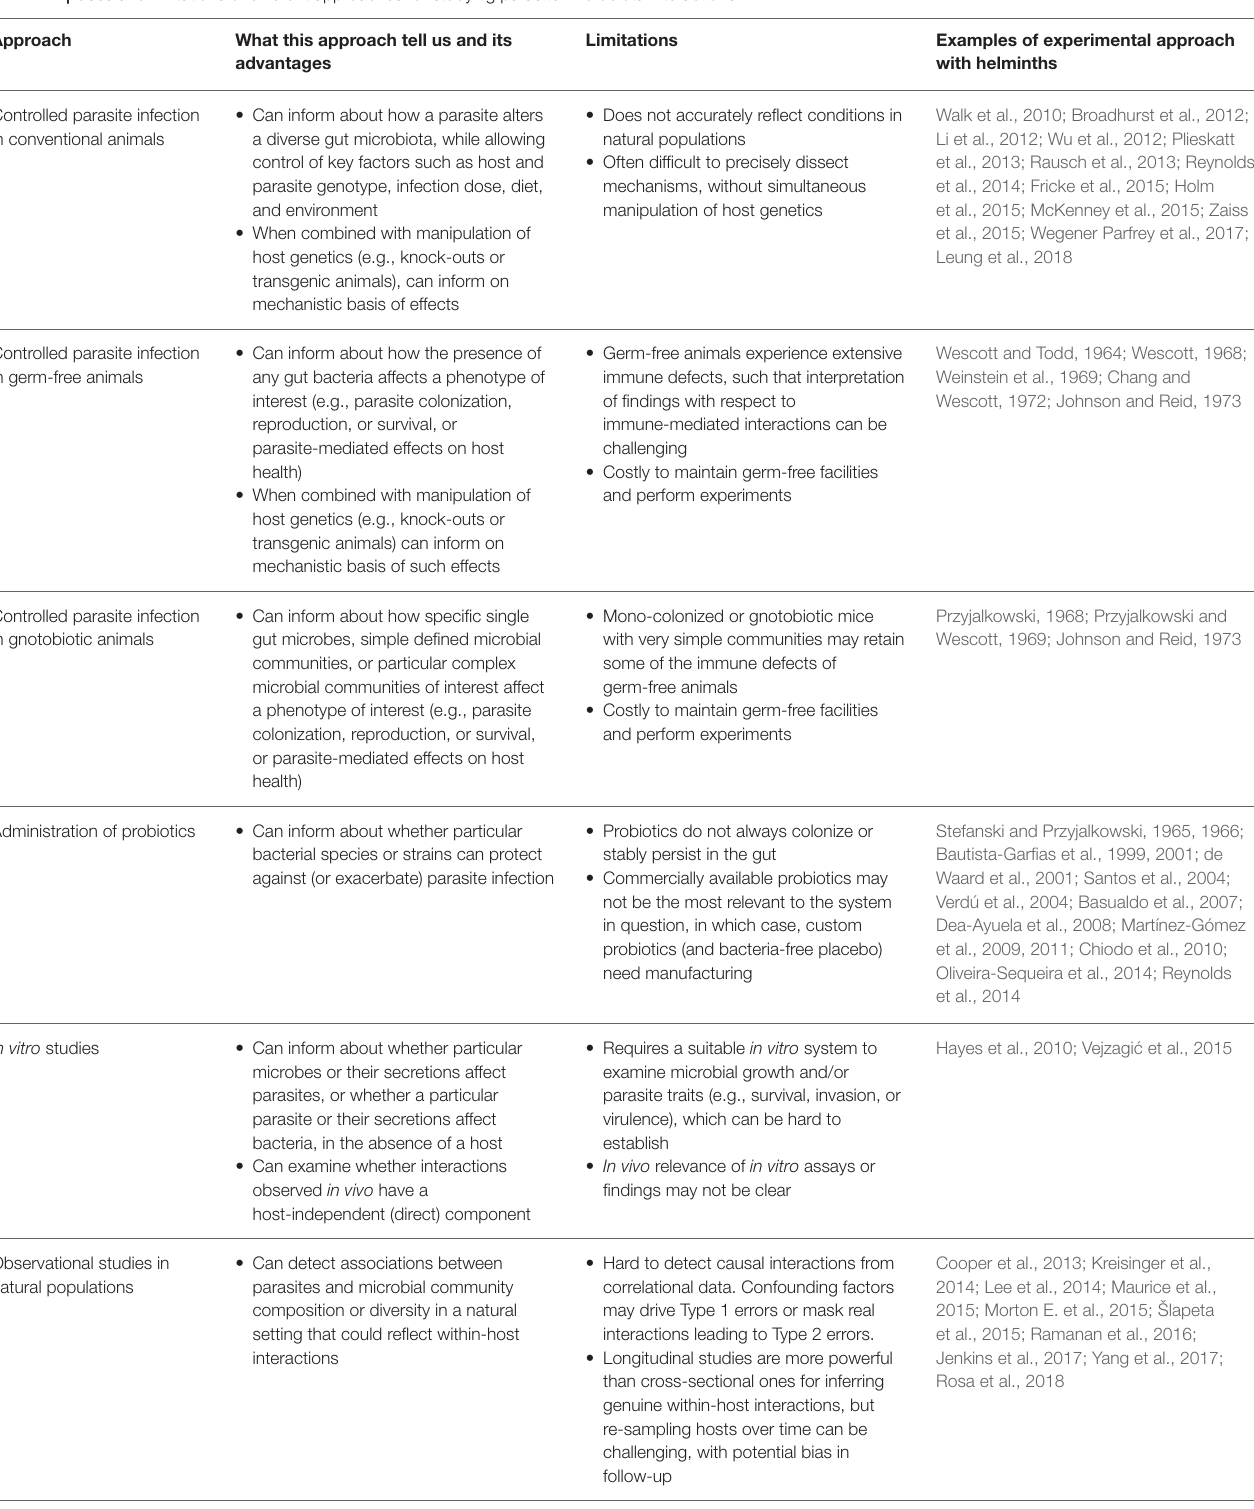
TABLE 2 | Uses and limitations of different approaches for studying parasite-microbiota interactions.